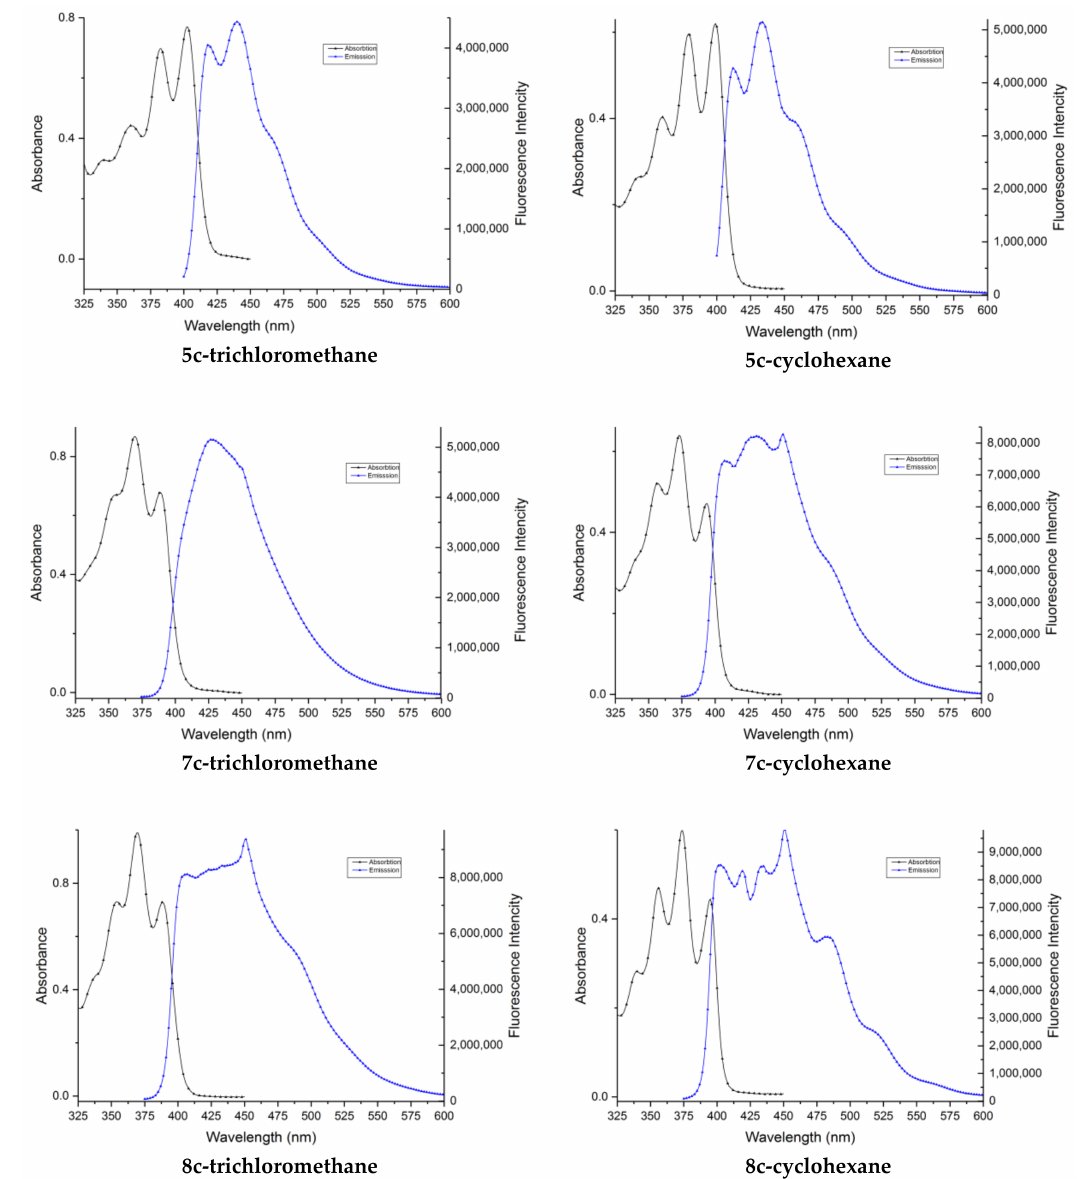
Figure 3. The absorption (black line) and emission (blue line) spectra of azasteroid derivatives 5c , 7c , and 8c in trichloromethane ( left column ) and cyclohexane ( right column ). The excitation wavelength was: 380 nm for sample 5c and 365 nm for samples 7c and 8c .